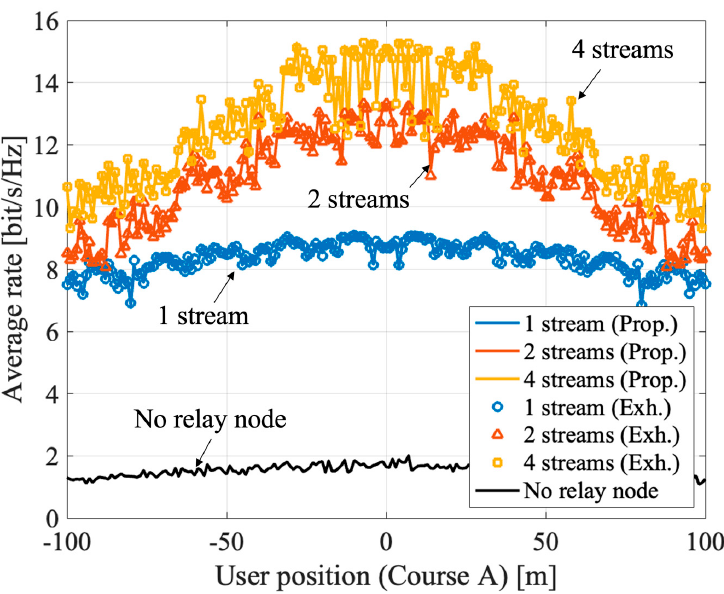
Figure 6. Average rate of massive relay MIMO with the proposed method in course A.